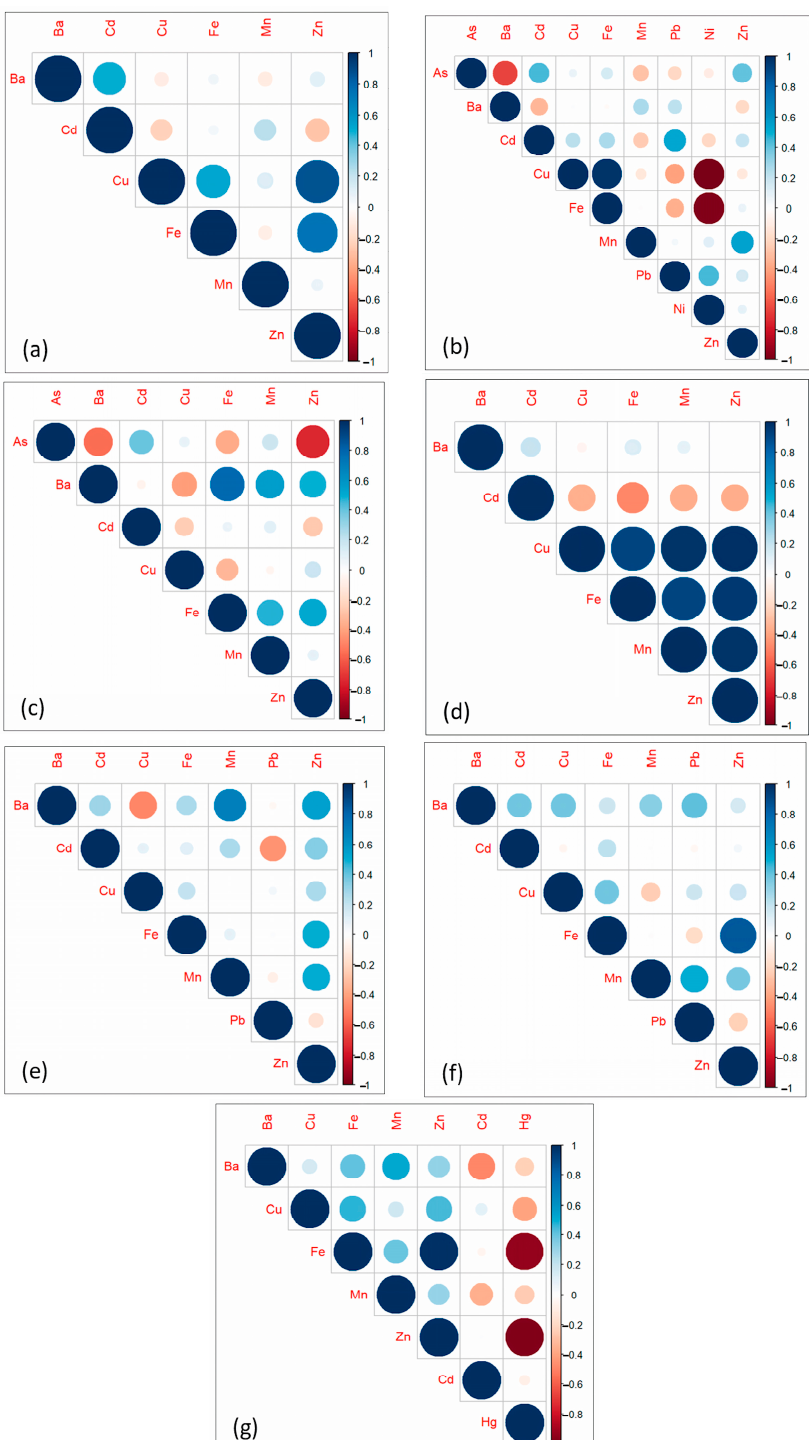
Figure 7. Correlogram of HMs in the ( a ) bone, ( b ) fins, ( c ) head, ( d ) meat, ( e ) skin, ( f ) tail, and ( g ) viscera of Tilapia